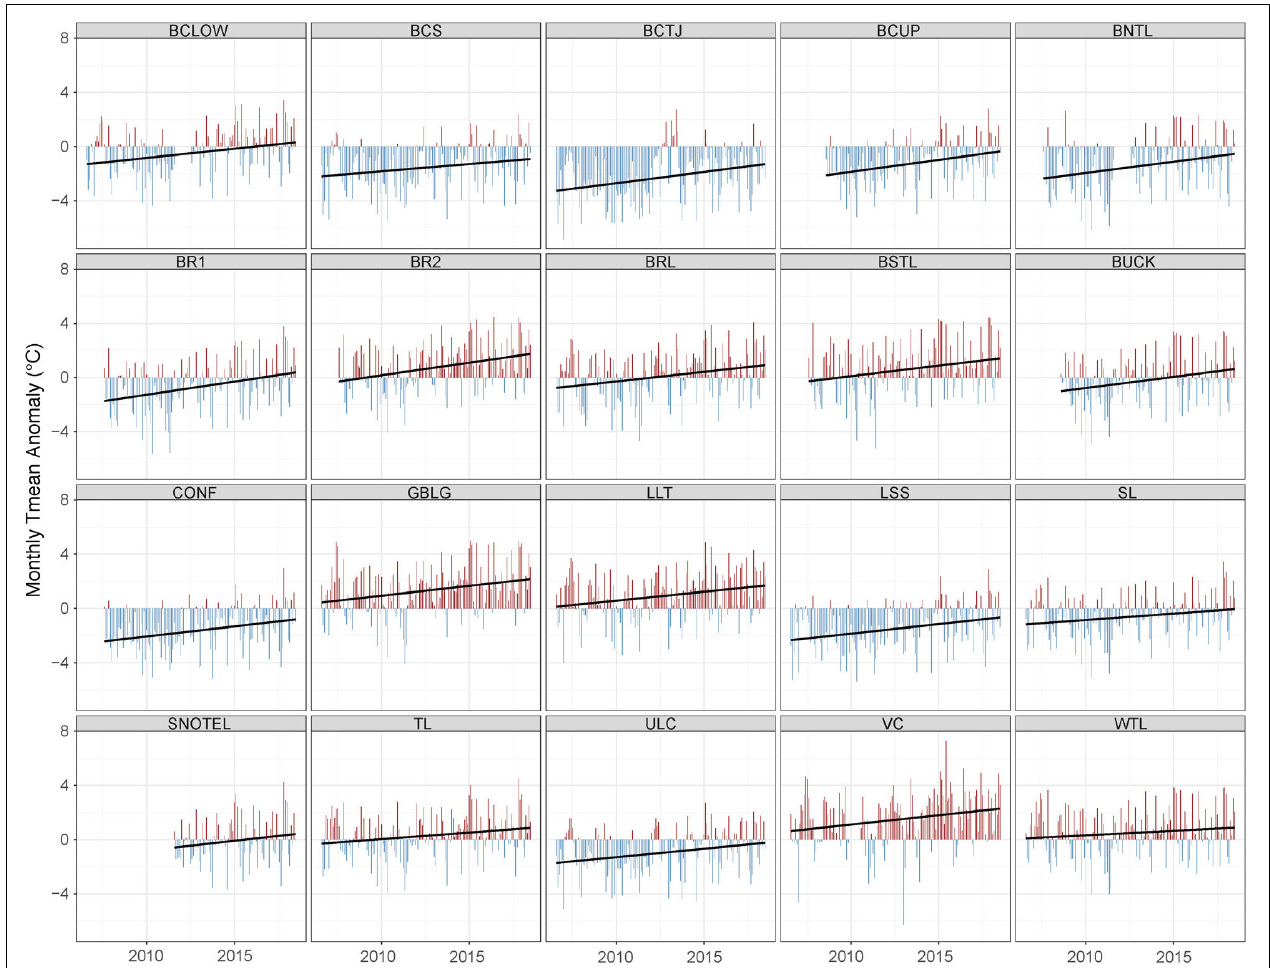
FIGURE 7 | Matrix of monthly T mean time series of anomalies at 20 ESN sensor sites. Red bars represent positive anomaly values and blue bars represent negative anomaly values. Overall anomaly trendlines are shown with a solid black line. SNOTEL and WTL sites have positive but not significant